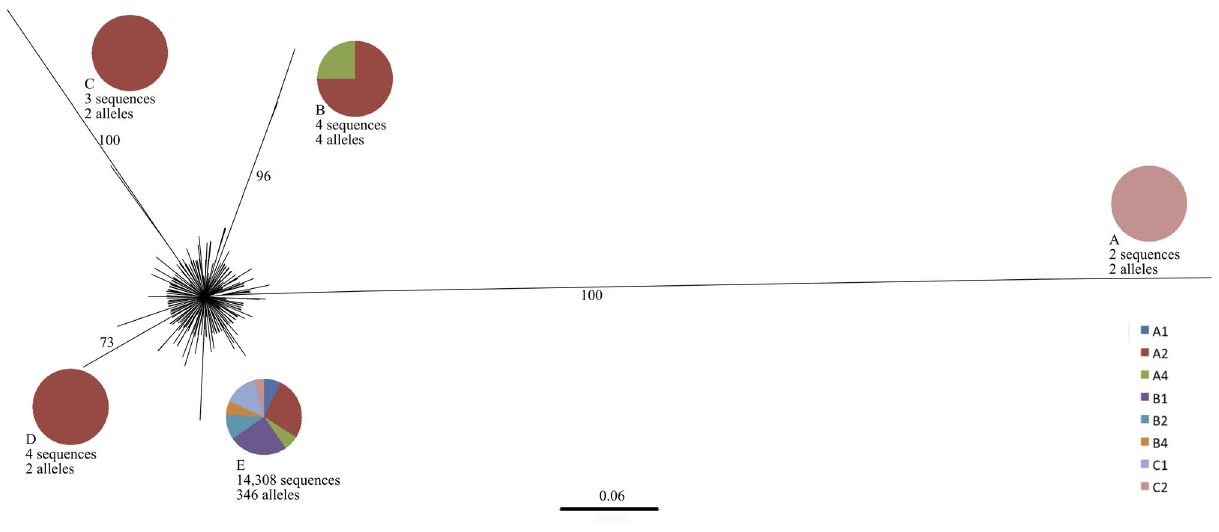
Figure 2. Phylogenetic analysis of genetic divergence between alleles (n=356, f=14,321, 92 nucleotide sites were used). Evolutionary relationships between alleles were inferred by maximum likelihood based on the Hasegawa-Kishino-Yano model of DNA evolution [46] with a discrete gamma distribution (5 categories (+G, parameter = 11.0677)). Statistical significance was tested with bootstrap replicates (n=1000); only values higher than 70 are depicted. Scale bar indicates number of substitutions per site. Pie charts indicate relative allele provenance for each allele group, as defined by bootstrap values >70. doi: